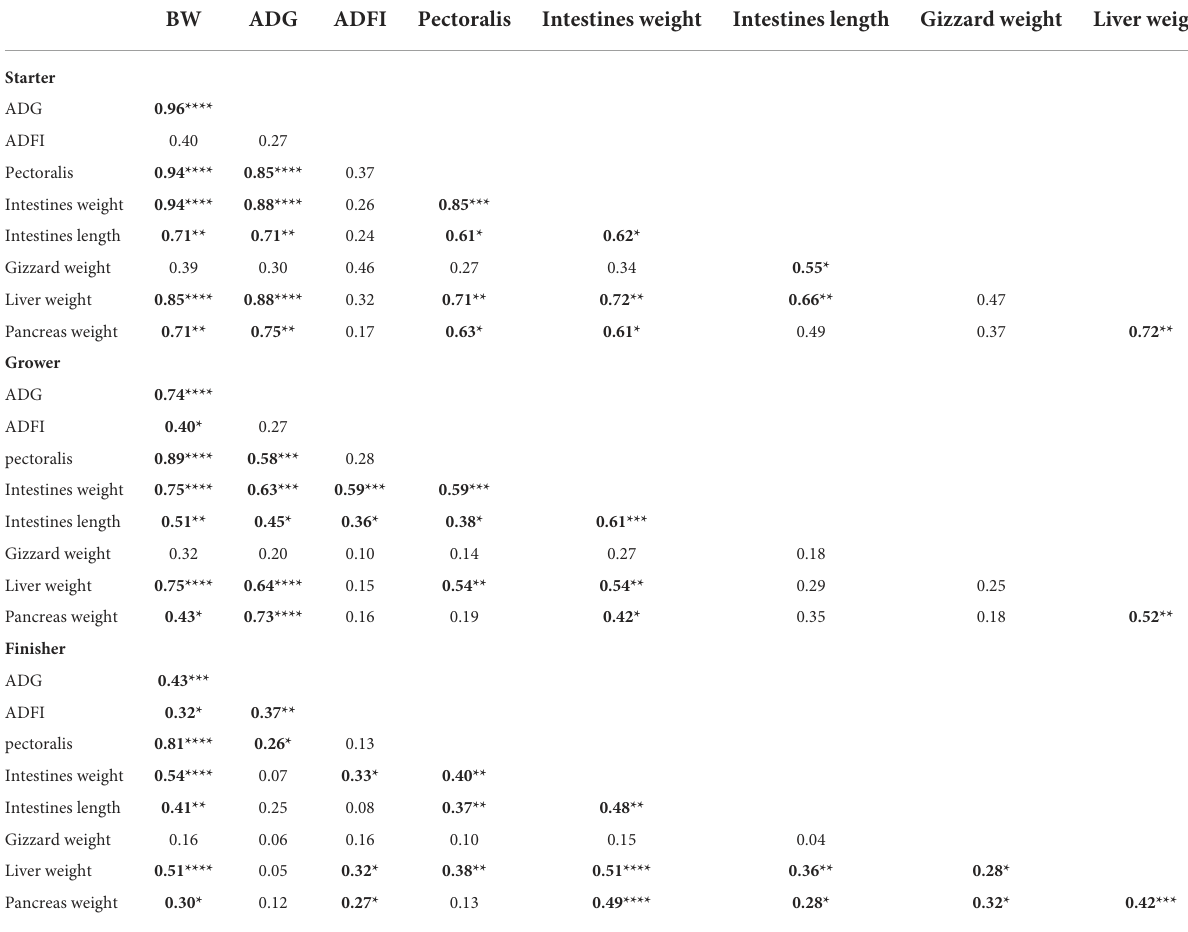
TABLE 2 Pearson correlations between performance parameters [bodyweight (BW), average daily gain (ADG), and average daily feed intake (ADFI)] and intestinal measurements [pectoralis (g), intestinal weight (g), intestinal length (mm), gizzard (g), liver (g), pancreas (g) in each phase (Starter, Grower,